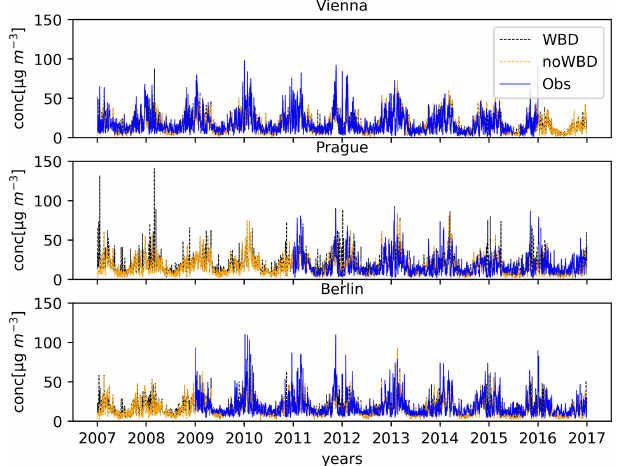
Figure 11. Same as Fig. 12 but for Munich, Budapest and